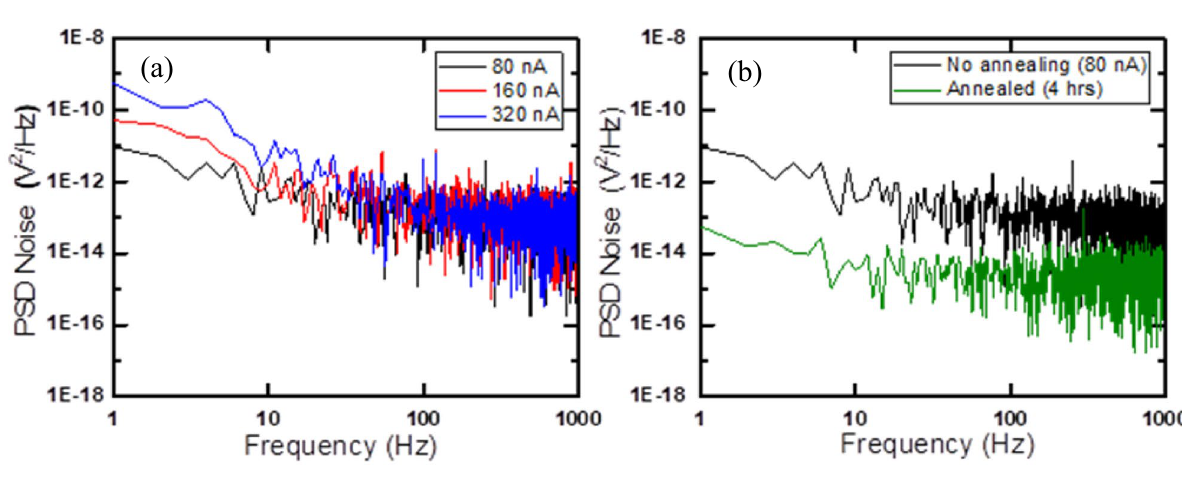
Figure 4. Voltage noise PSD of the bottom microbolometer ( a ) before annealing for three different biased current from 80 to 320 nA ( b ) annealing in vacuum for 4 h at 80